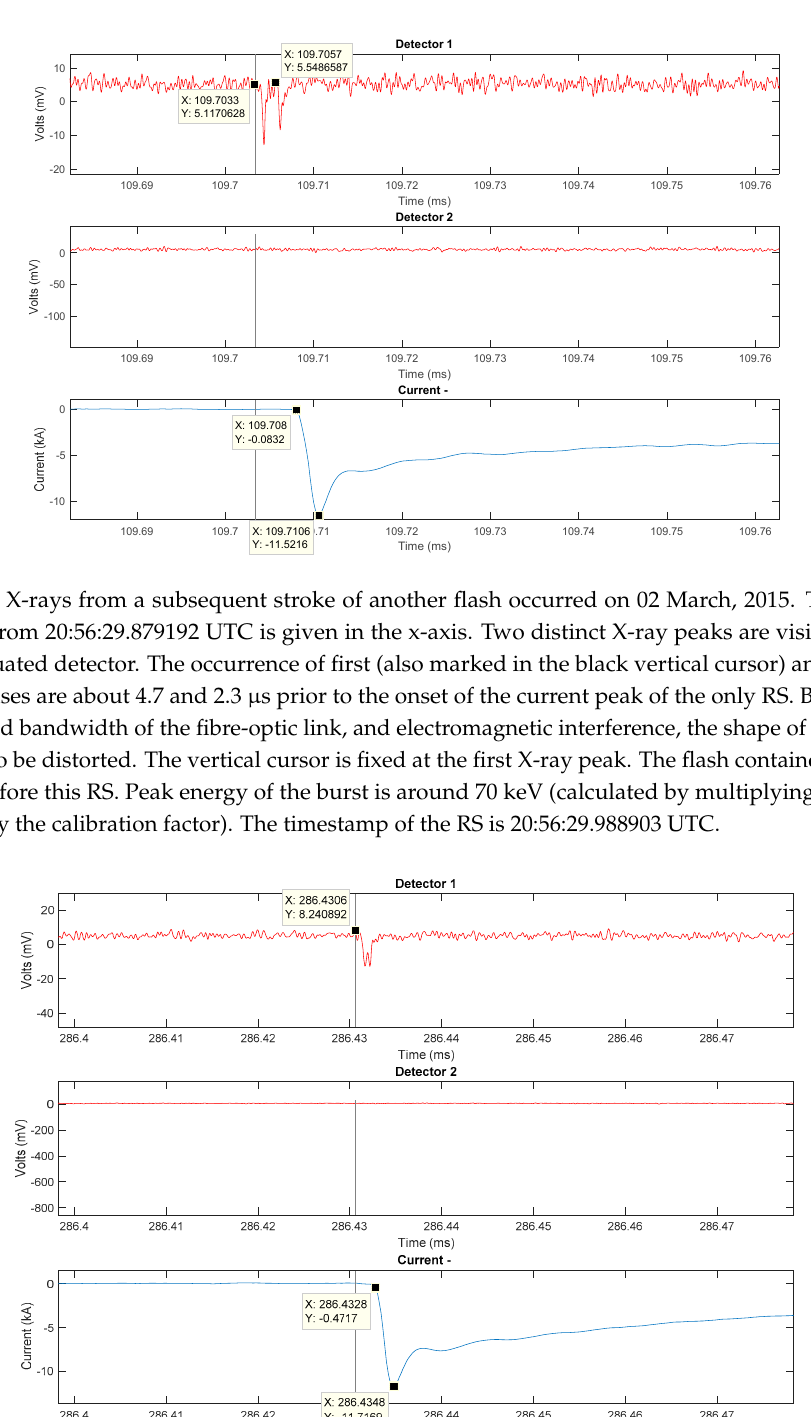
Figure 7. The complete time window of the flash occurred on 02 March, 2015 corresponding to the RS shown in Figure 6. The time t = 0 corresponds to 20:54:37.247308 UTC. The current peak and the X- ray burst shown in Figure 6 are indicated by black vertical arrows.